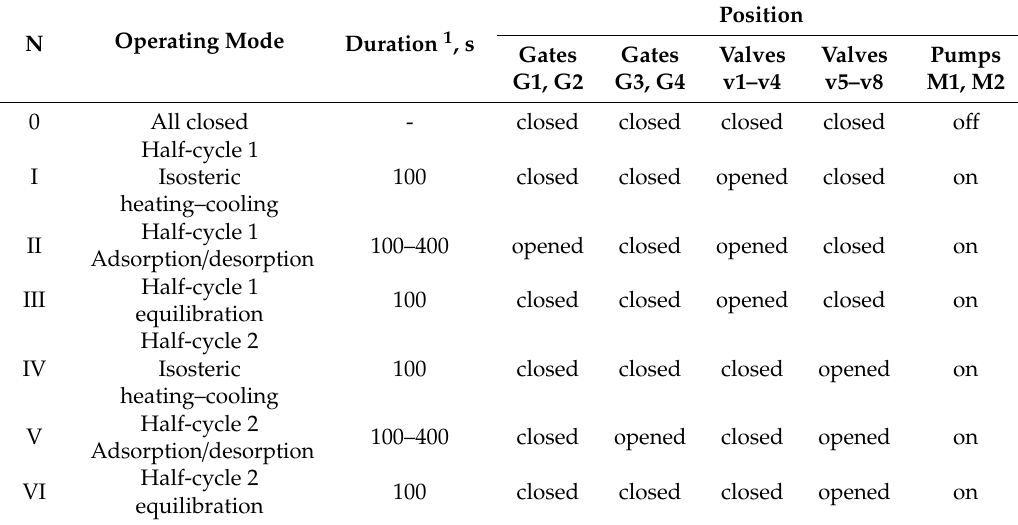
Table 1. Working diagram of the test